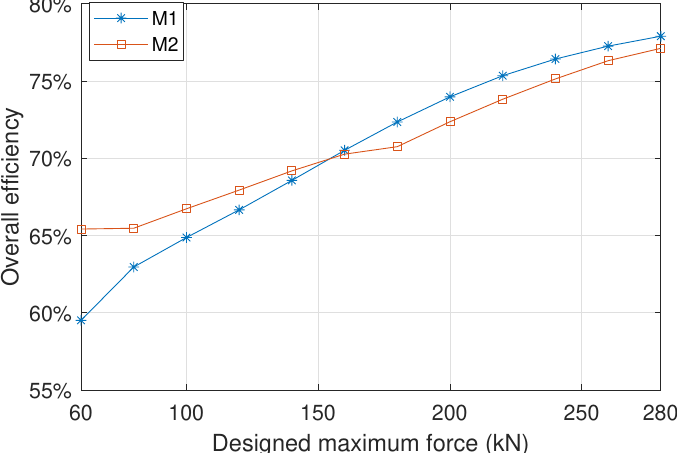
Figure 7. Scaled translator, stator and stack lengths for different designed maximum generator forces.